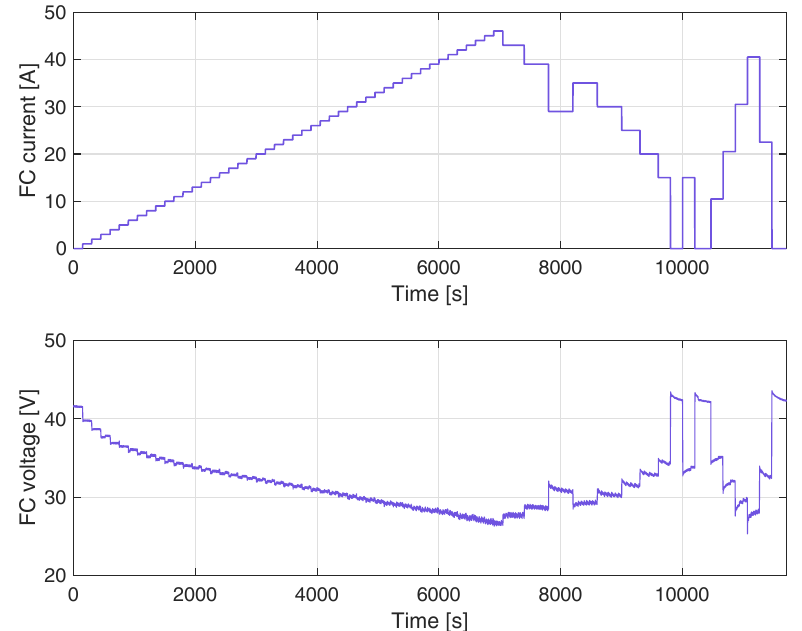
Figure 8. Measurements from the second FC load current profile, used to select the training samples of the SVM